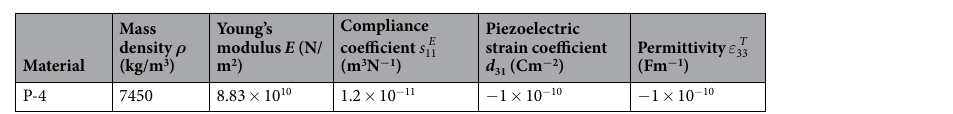
Table 2. The material parameters of the piezoelectric